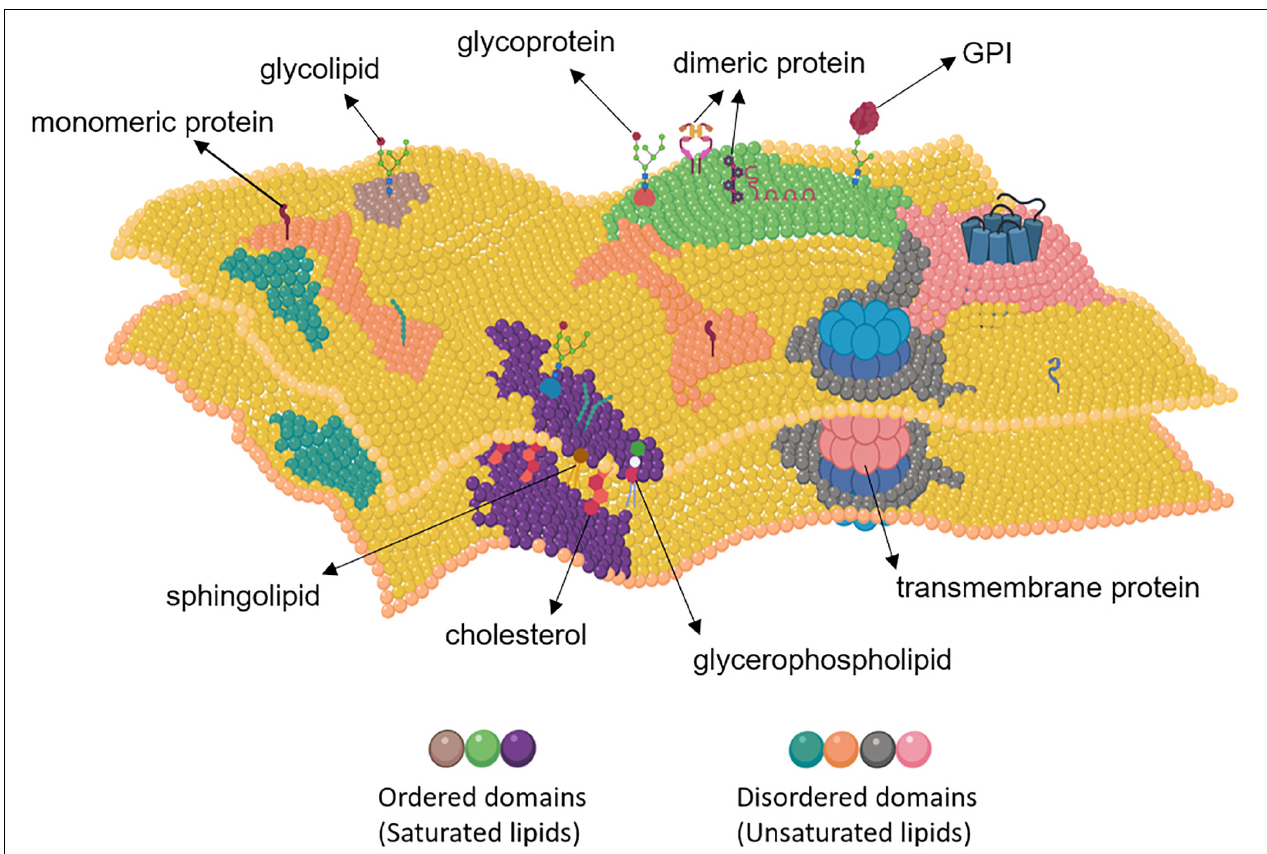
FIGURE 1 | Structure of the plasma membrane. The plasma membrane consists of ordered and disordered domains. Basically, ordered domains are enriched in cholesterol, sphingolipids, glycerophosholipids, glycosylphosphatidylinositol (GPI)-anchored proteins, glycoproteins, dimeric proteins, and saturated lipids, whereas the disordered domains usually contain monomeric and transmembrane proteins and unsaturated lipids. Created with